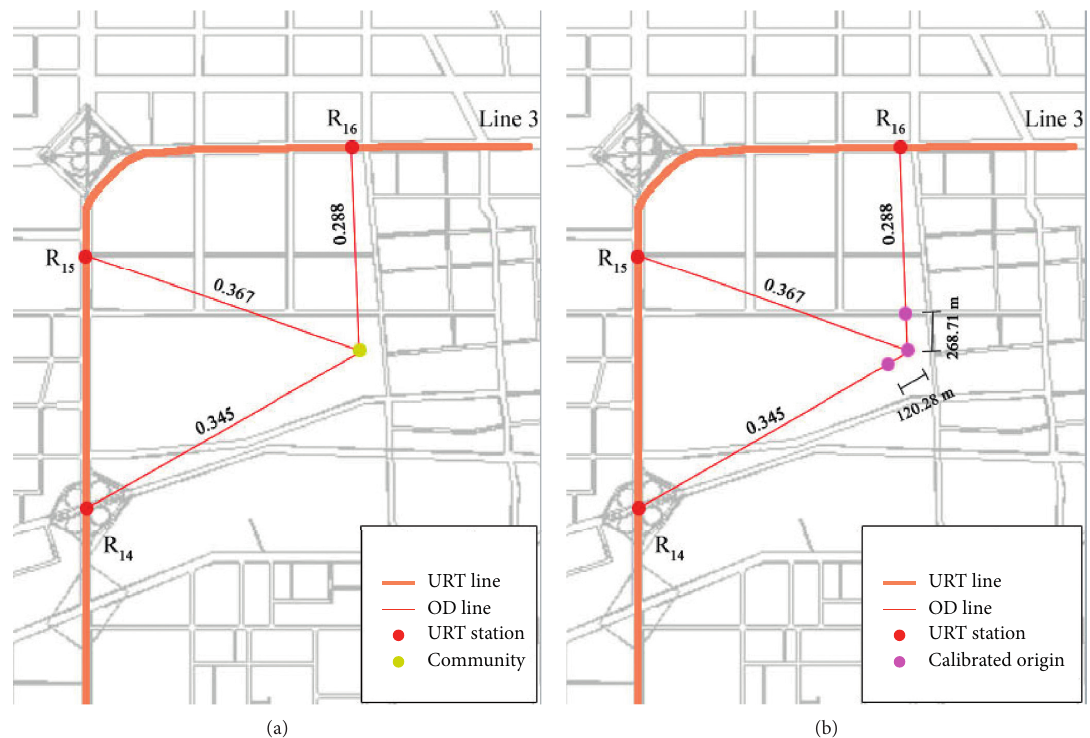
Figure 4: Outputs from the improved Huff model and origin calibration.